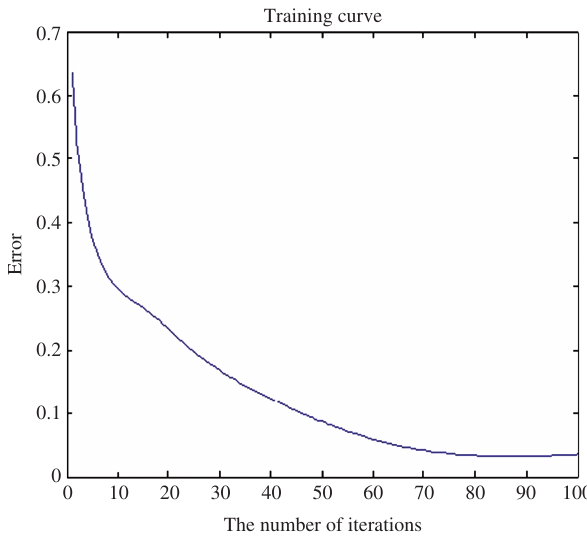
Figure 7. Training Curve of the